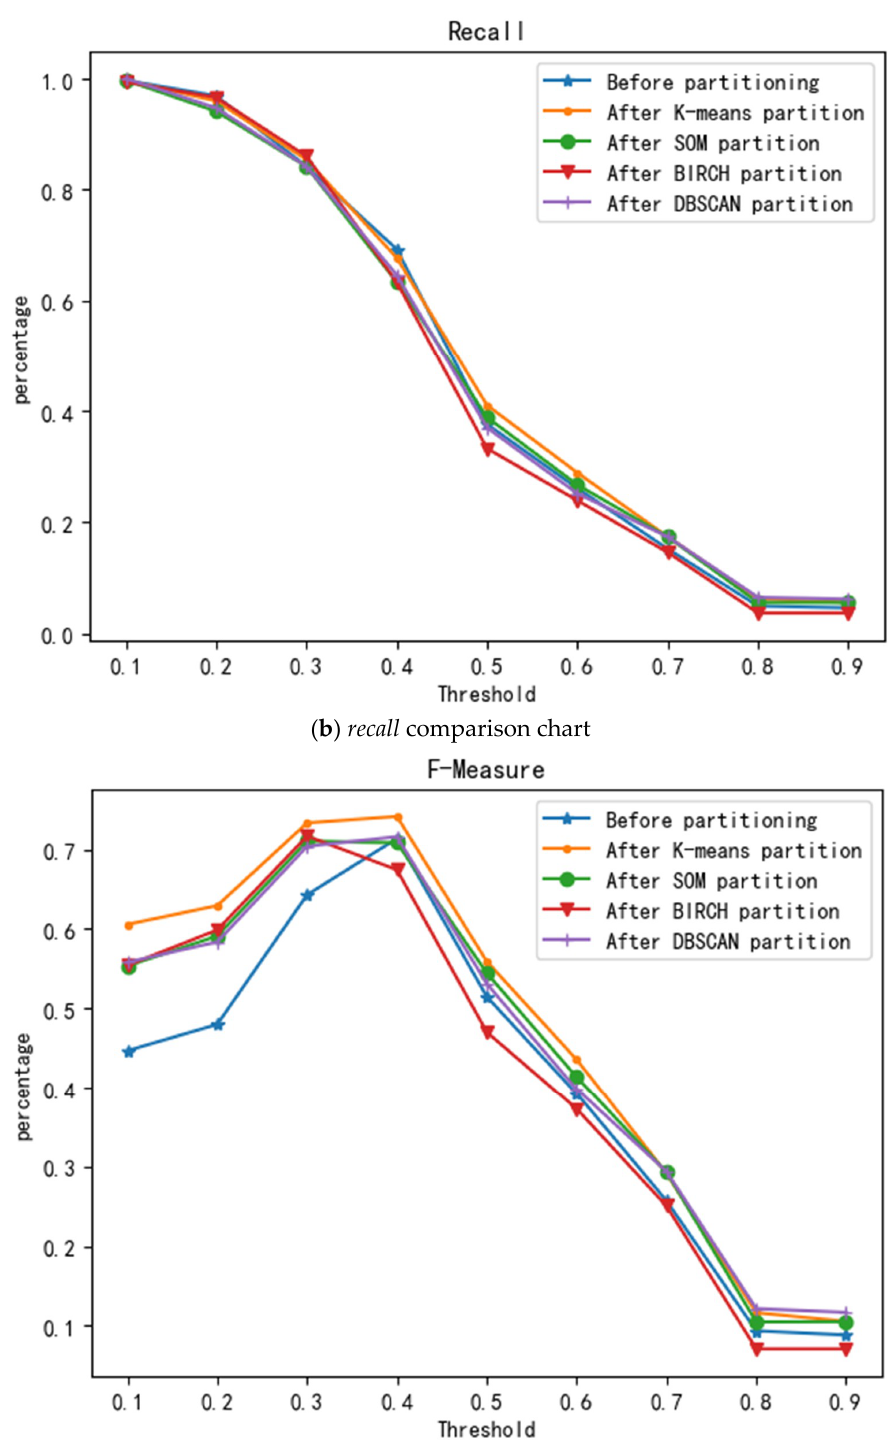
Figure 11. Effect before and after partition.